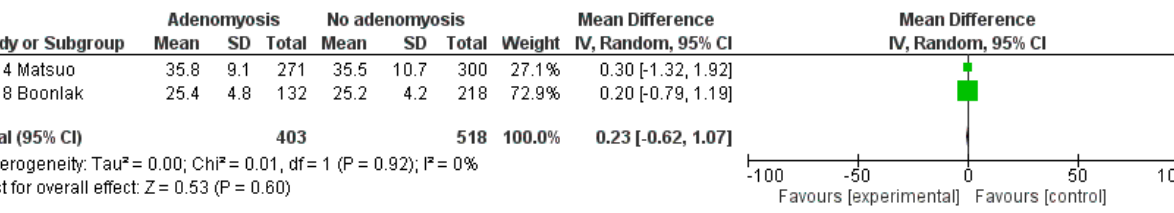
Figure 2. Forest plot of mean difference in mean ± standard deviation (SD) of body mass index between EC patients with and without adenomyosis, for each included study and as pooled estimate.